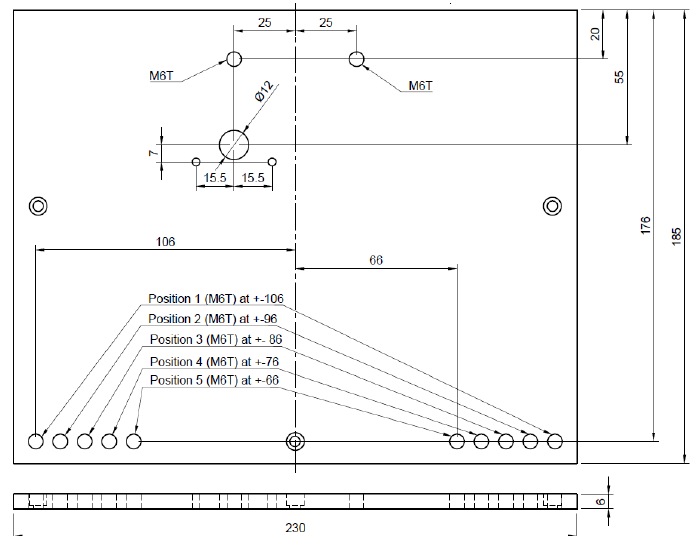
Figure 7. Schematic representation of the baseplate. Sizes shown are just for reference and have not been optimized. The design will require adjustments.